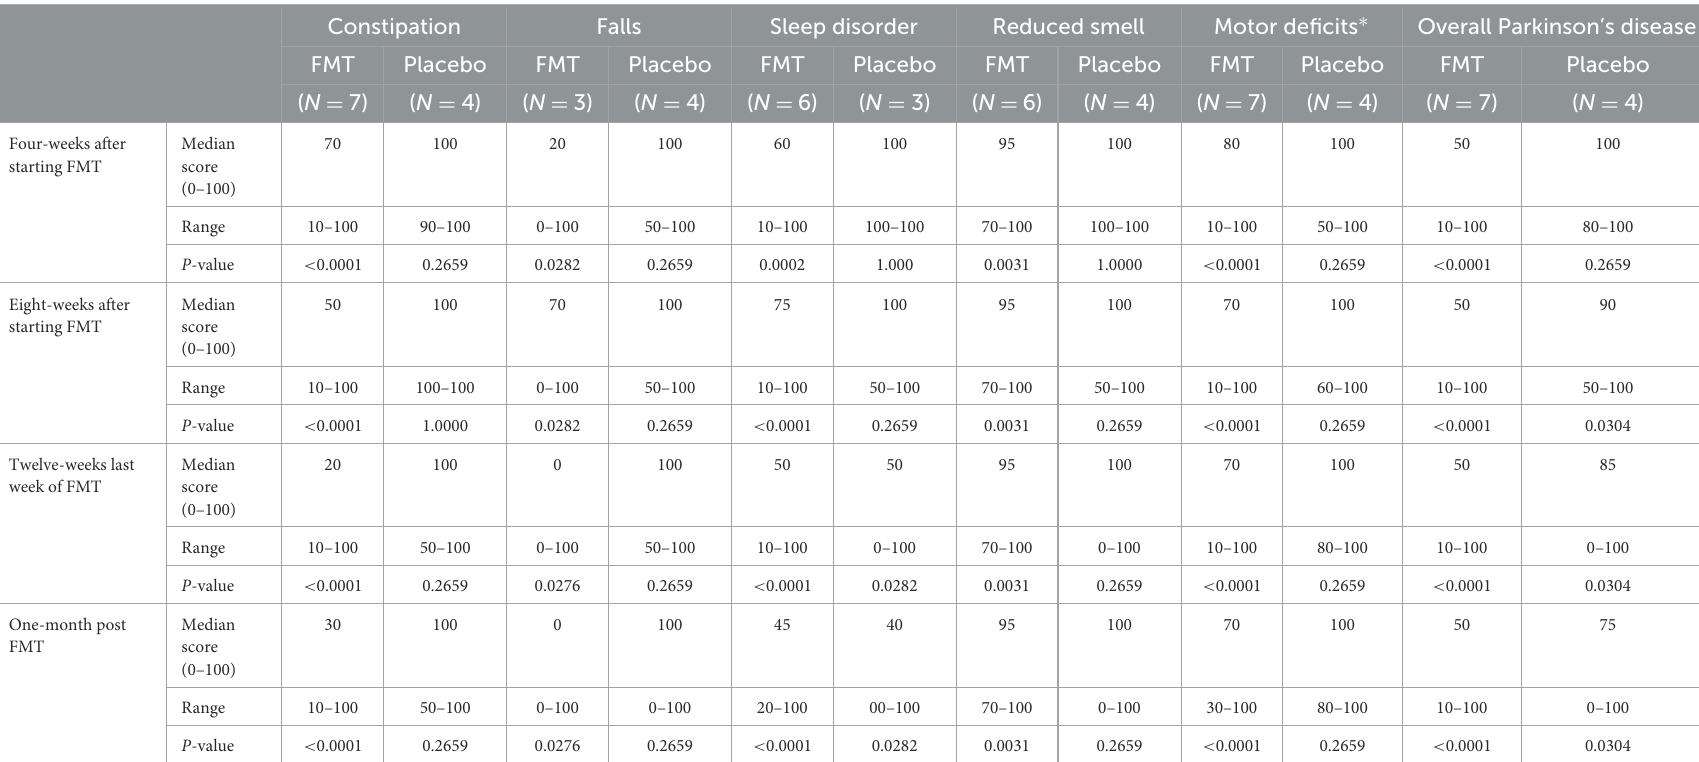
TABLE 2 Subjective improvement in symptoms: number subjects reporting improvement and median percentile of improvement after beginning treatment compared with pre-treatment value of 100, during and after 12-weeks of oral fecal microbiota vs. placebo using a visual analog scale